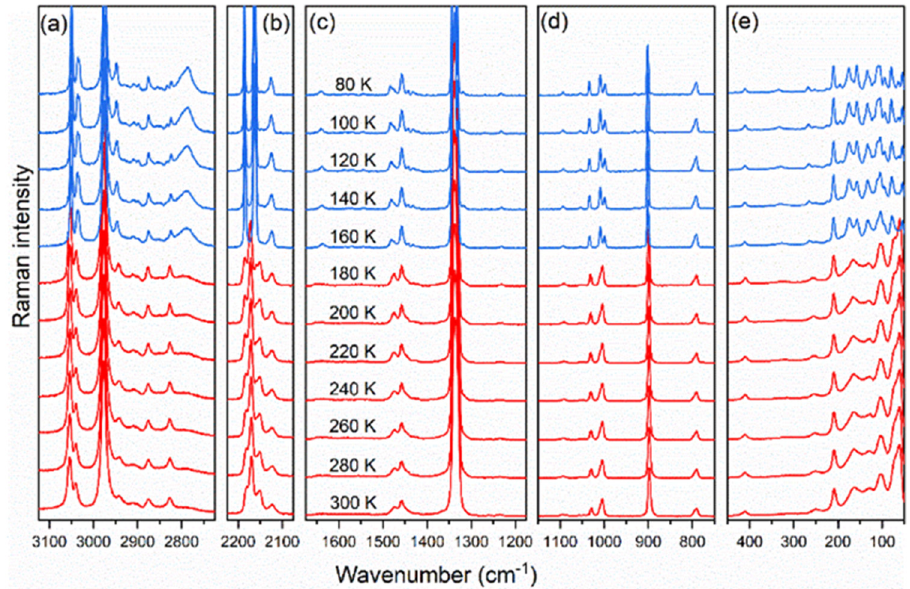
Figure 3. Thermal evolution of Raman spectra measured for DMAZnD at selected temperatures in a spectral range: ( a ) 3150 − 2750 cm − 1 , ( b ) 2250 − 2050 cm − 1 , ( c ) 1650 − 1150 cm − 1 , ( d ) 1150 − 750 cm − 1 , (e) 450 − 50 cm − 1